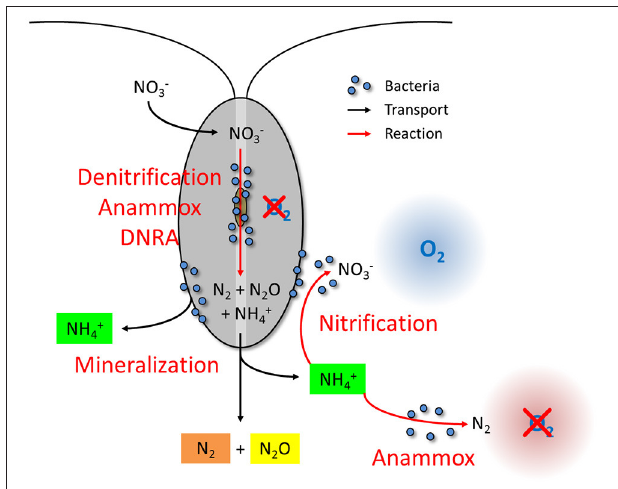
FIGURE 6 | Conceptual scheme of zooplankton-carcass-associated N-cycling and potential effects on pelagic N-cycling. Microbial N-cycling may take place in the anoxic interior and on the exoskeleton of zooplankton carcasses. Anaerobic N-cycling associated with zooplankton carcasses contributes to pelagic N-loss both directly via N 2 and N 2 O production (through denitrification and anammox) and indirectly via NH + 4 production (through DNRA and mineralization) that may fuel free-living anammox bacteria in anoxic water layers. Carcass-derived NH + 4 may also fuel microbial nitrification in oxic and hypoxic water